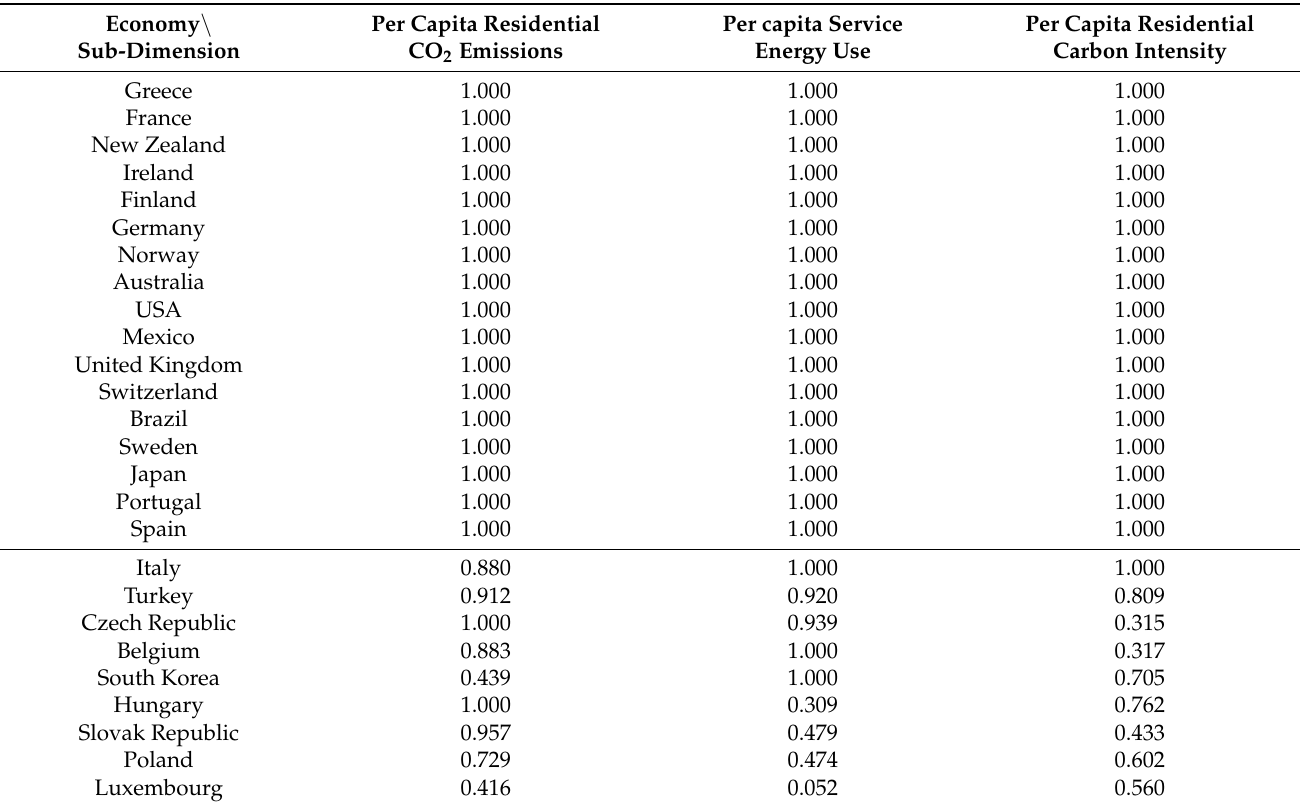
Table A4. Output efficiency scores in the environment